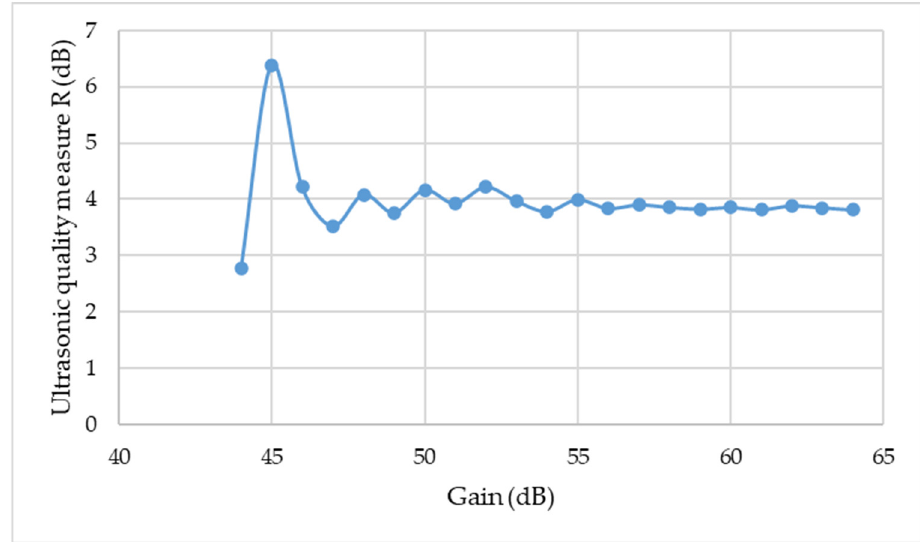
Figure 10. Dependence of the ultrasonic R measure on the amplification of the ultrasonic wave pulse.